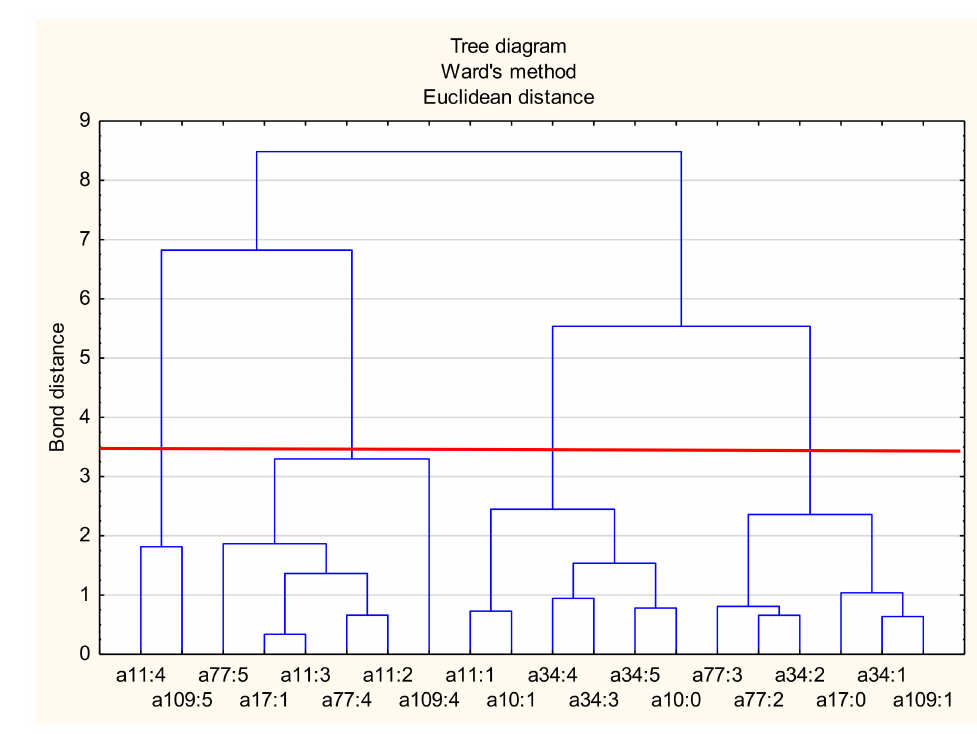
Figure 1. Diagram of hierarchical classification of variable categories—Ward’s method. Source: own